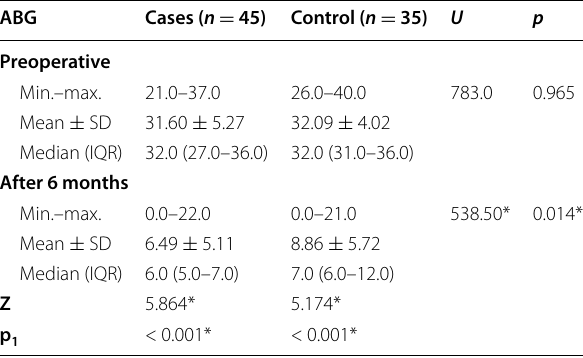
Table 3 Comparison between the graft taken cases among the two studied groups regarding ABG preoperative, and 6 months postoperatively, along with a comparison between preoperative and postoperative ABG in both groups